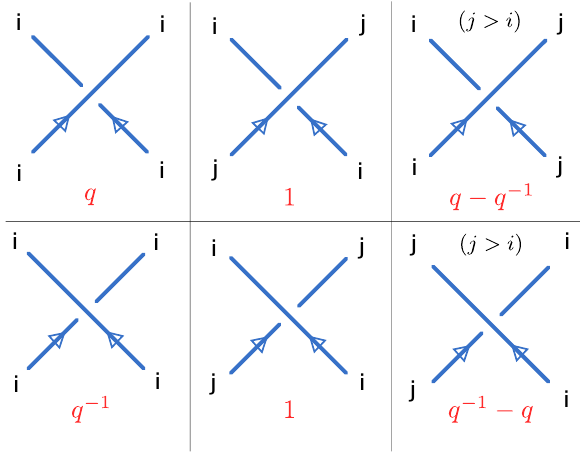
Figure 2 . Multiplicative weights in the state sum model, associated to labeled crossings in a knot